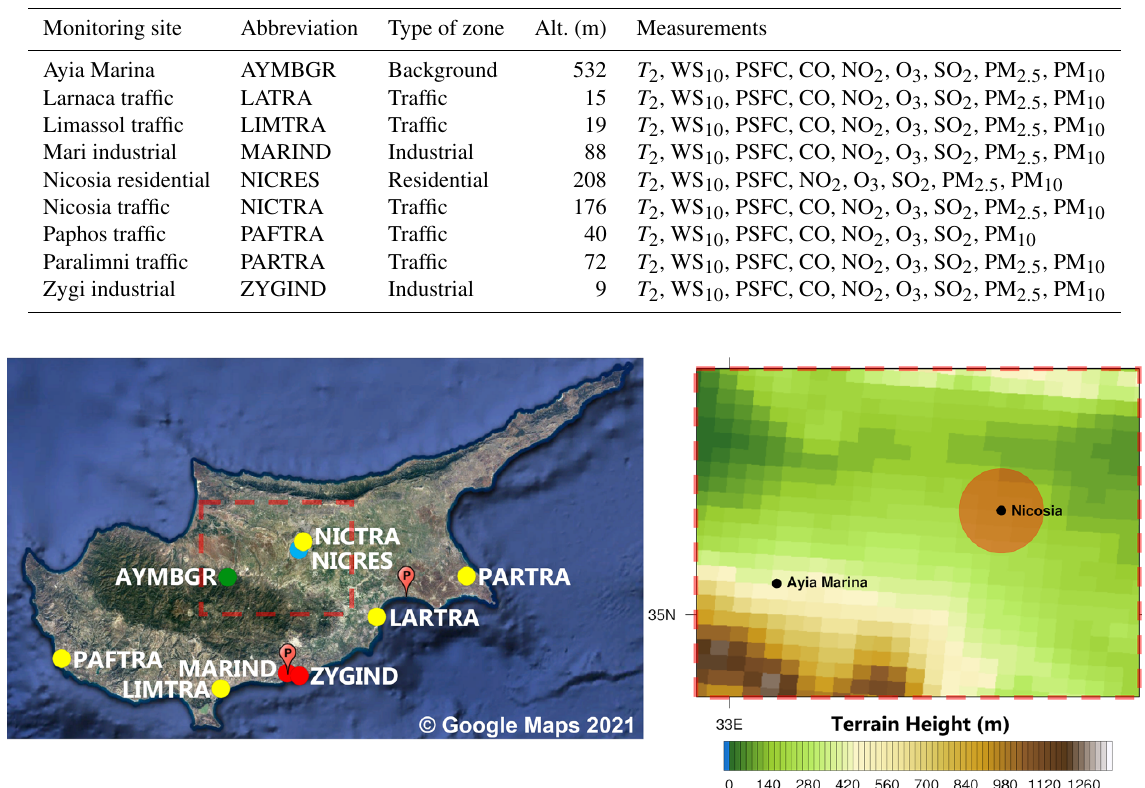
Table 2. Monitoring stations.